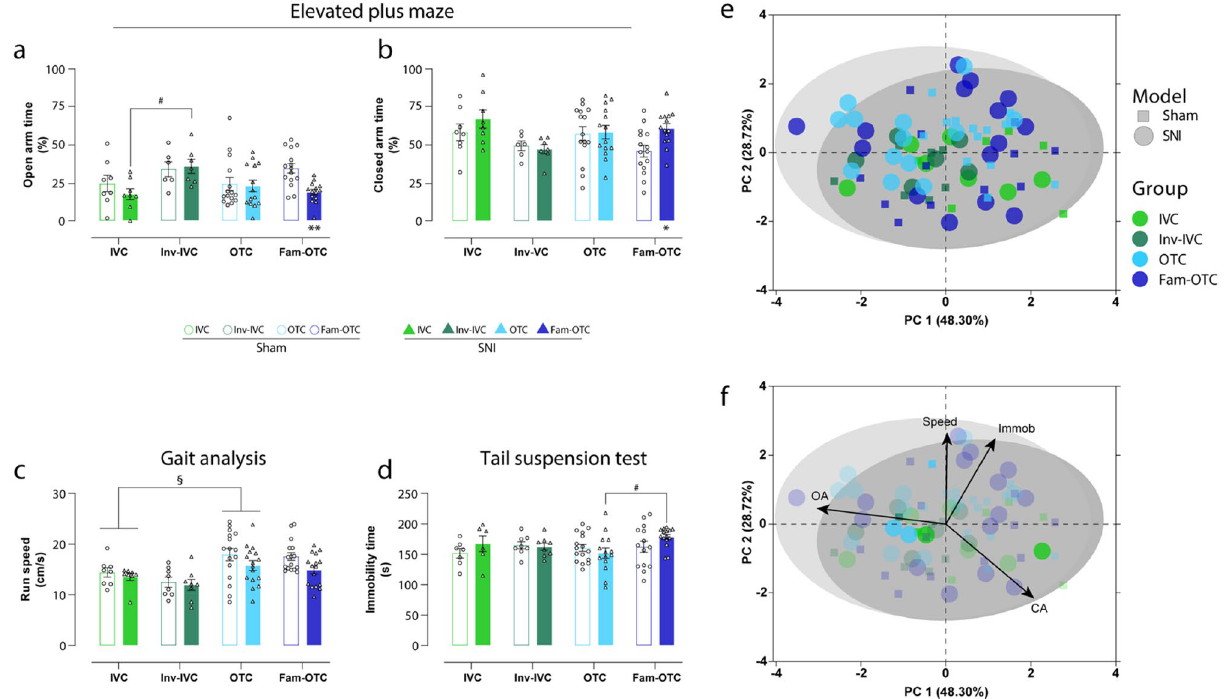
Figure 2. Different cage conditions produce distinct emotional phenotypes. ( a, b ) Only in experimenter familiarized mice in open top cages (Fam-OTC), a significant reduction of open arm (OA) and increased closed arm (CA) time was detected compared to sham, indicating anxiety-associated behavior. No other group showed such an effect of spared nerve injury (SNI) mice compared to sham (control). A significant increase in OA time in mice of the inverted (Inv) day-night cycle in individually ventilated cages (Inv-IVC) compared to IVC and a trend of reduced CA time was detected, indicating a reduction in anxiety-related behavior. ( c ) No significant change in moving speed between sham and spared nerve injury (SNI) and housing conditions was observed in any group. ( d ) Depression-like behavior triggered by peripheral neuropathy was not found. However, immobility time was significantly higher in the Fam-OTC group than in the OTC group in SNI mice. ( e, f ) Multivariate analysis to characterize the emotional phenotype induced by peripheral neuropathy showed that the SNI phenotype was characterized by decreased OA, increased CA, and immobility time. Results are expressed as mean ± SEM. N = 6–8 for all IVC and Inv-IVC groups and N = 14–16 for all OTC and Fam-OTC groups. Two-way ANOVA (repeated measures based on GLM) followed by Dunnett’s multiple comparison test. *For comparison to sham; p values: * ≤ 0.05, ** ≤ 0.01, *** ≤ 0.001. #For comparison to husbandry conditions; p values: # ≤ 0.05, ## ≤ 0.01, ### ≤ 0.001. §For comparison between IVC and OTC; p values: § ≤ 0.05, §§ ≤ 0.01, §§§ ≤ 0.001. The principle components (PC) were selected to determine the eigenvalues. MANOVA was used for cluster analysis in PCA (Table